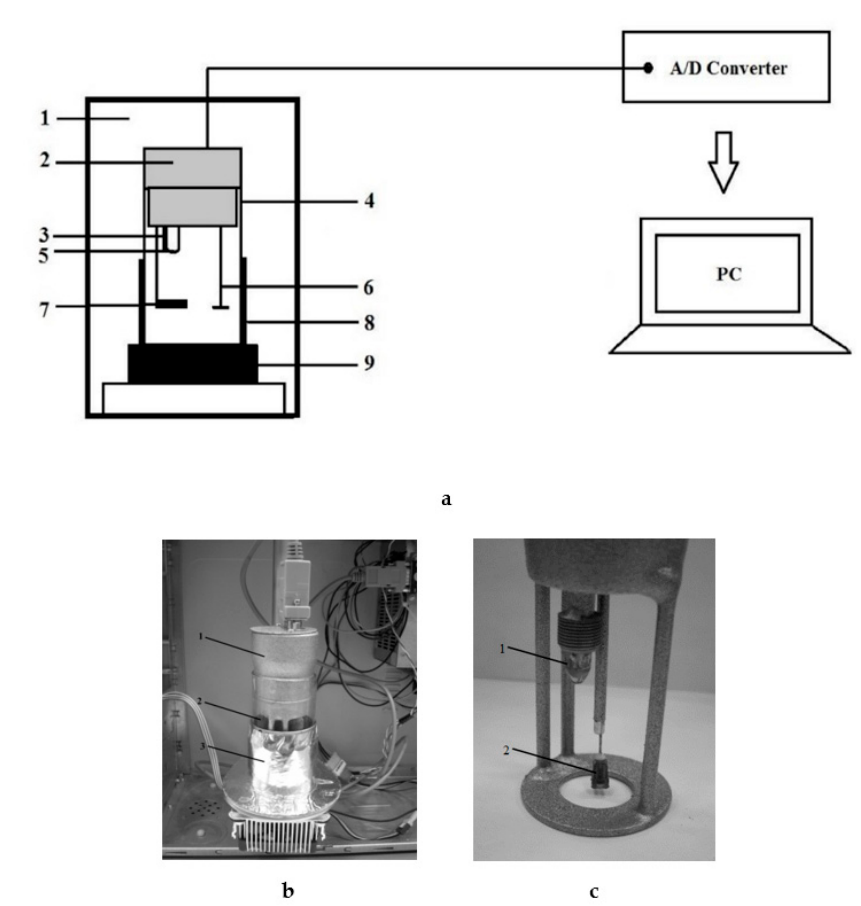
Figure 2. ( a ) Scheme of measuring cell: (1) light-tight housing, (2) cover with built-in measurement system, (3) photosensor, (4) glass vessel, (5) photodiode, (6) stirrer, (7) light reflector, (8) thermal insulation layer, (9) thermostat, ( b ) Image of the measuring device: (1) the measuring cell, (2) glass vessel, (3) metal vessel with thermal insulation layer, ( c ) The measuring cell: (1) photosensor and photodiode of the detecting system, (2) stirrer.